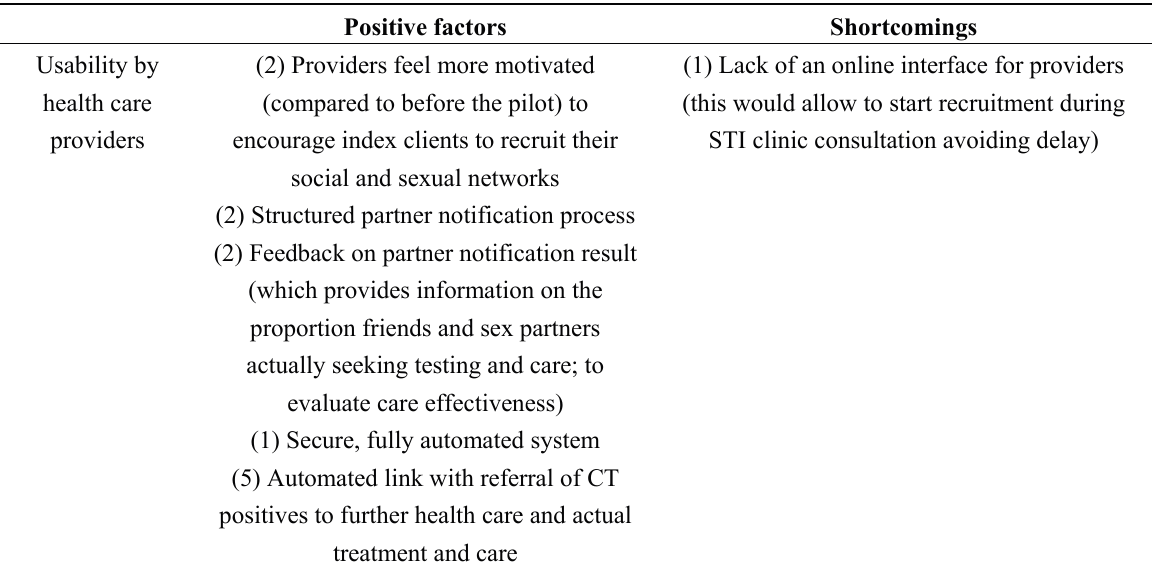
Table 3. An evaluation of use of the web-based screening strategy; a summary of the positive factors and